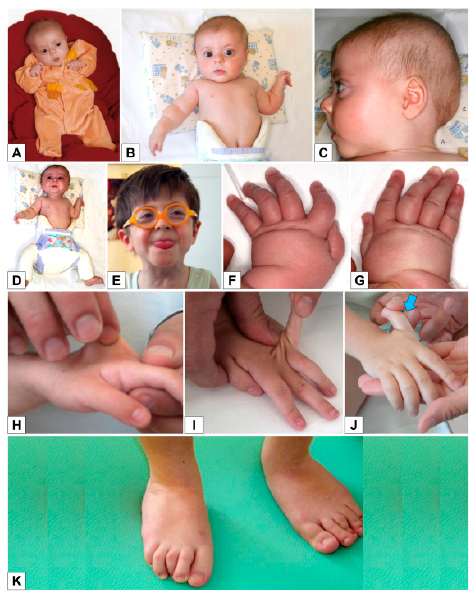
Figure 2. Patient 1 A ) Age 3 months: ulnar deviation of fingers; B ) Age 3 months: round flat face, mild